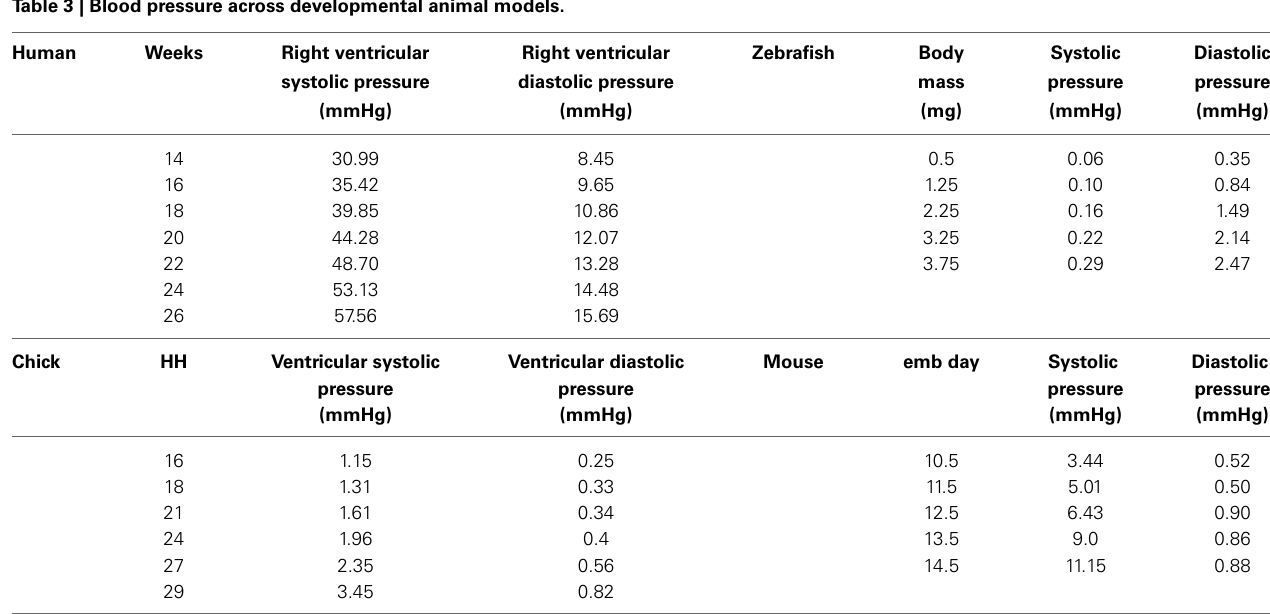
Table 3 | Blood pressure across developmental animal